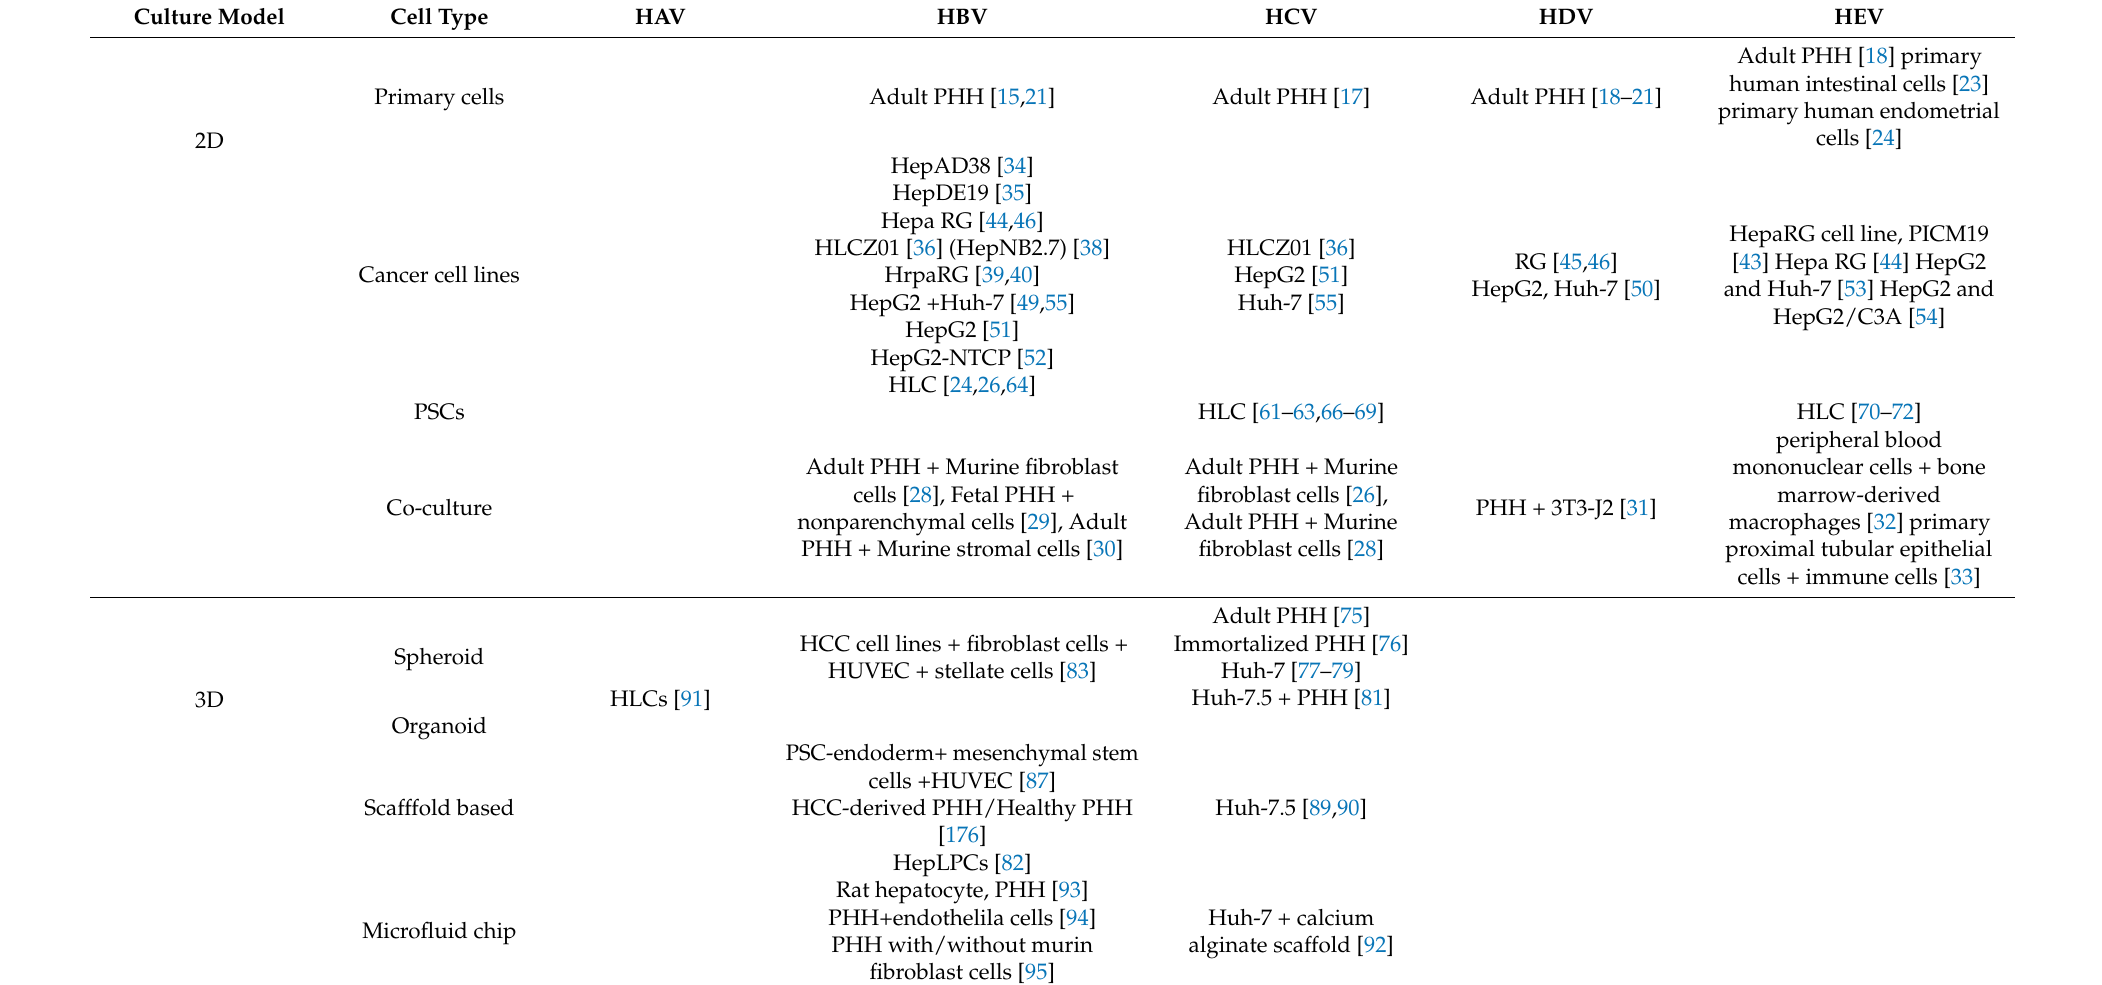
Table 1. Summary of various tissue culture models for hepatotropic